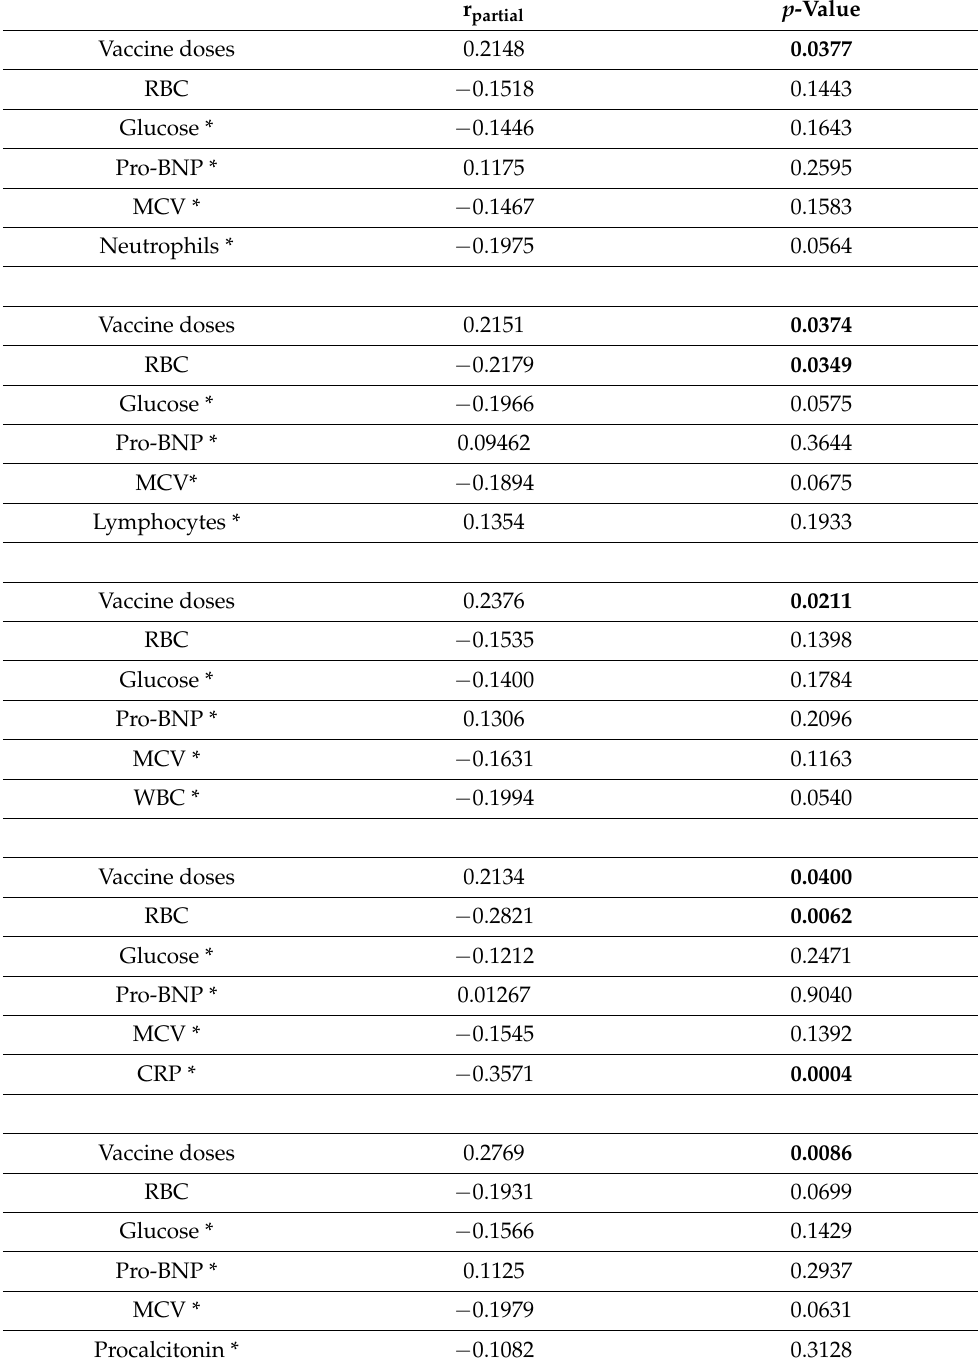
Table 3. Correlation between P/F ratio and demographic, clinical, and laboratory characteristics of the studied population on admission, obtained by multivariate regression